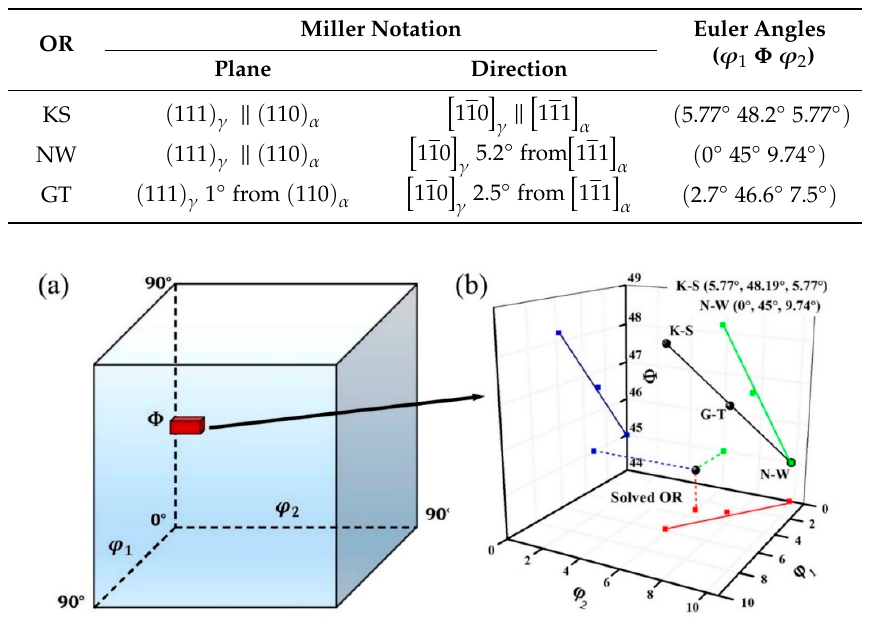
Figure 2. ( a ) Position of reduced solution space in the entire space of Euler angles. ( b ) Range of the reduced solution space.